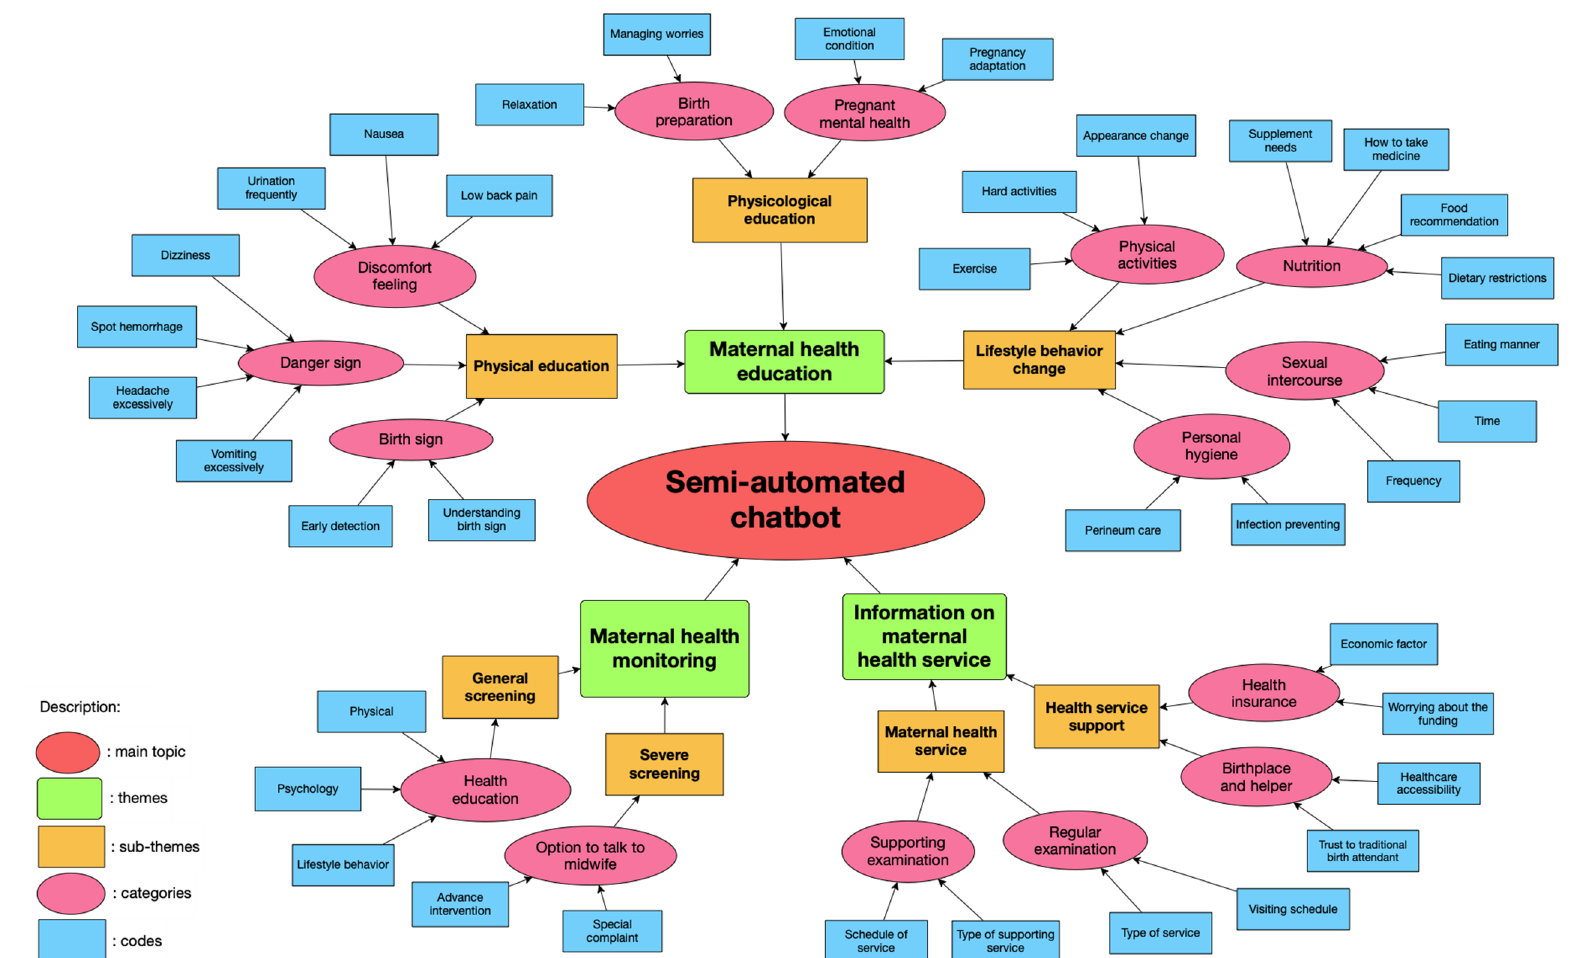
Figure 6. The conceptual map.